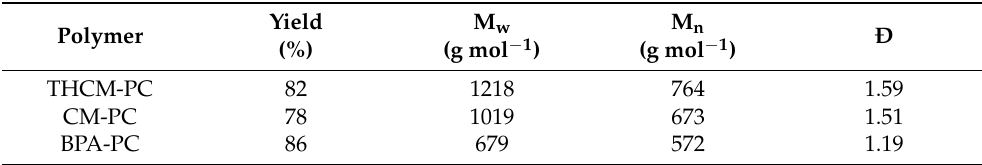
Table 3. Polymerization yield of prepared PCs and related polystyrene-equivalent average molecular weights and dispersity values measured by gel permeation chromatography (GPC).